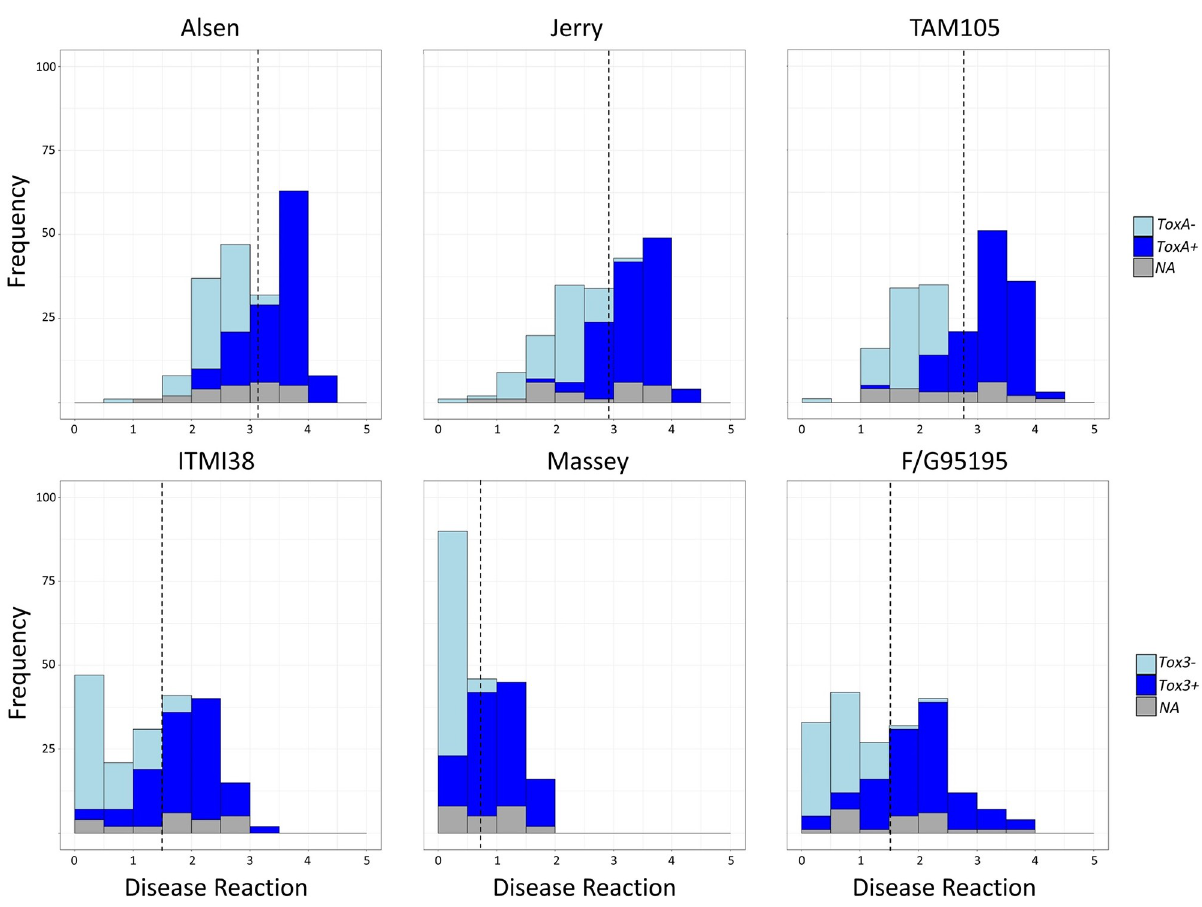
Fig 3. Histograms depicting the distribution of disease reactions to 197 P . nodorum isolates on wheat lines Alsen ( Tsn1 ), Jerry, TAM105, ITMI38 ( Snn3 ), Massey, and F/G95195. Disease reactions are displayed in bins along the x-axis and frequency is illustrated on the y-axis. Bars are shaded to illustrate the proportion of presence/absence of the corresponding effector ( SnToxA or SnTox3 ) or missing data (NA) per bin. Light blue corresponds to the absence of the effector, dark blue corresponds to the presence of the effector, and grey corresponds to missing data.